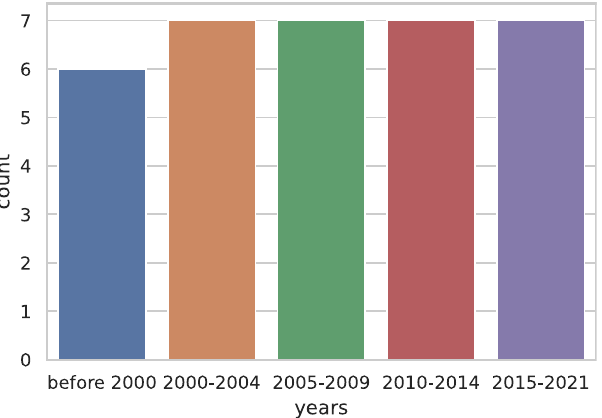
Fig. 2 Year-wise distribution of movies. Bar graph showing the distribution of the selected movies based on their published year.